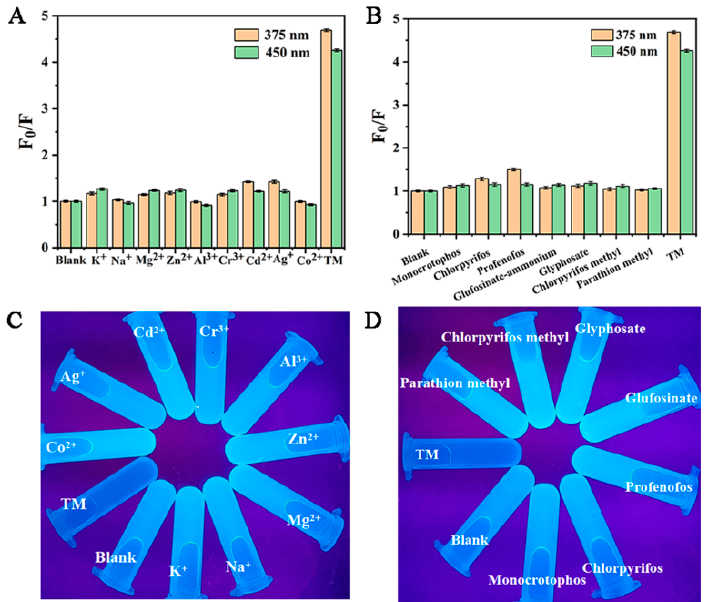
Figure 7. Cu-CDs selectivity to different metal ions ( A ) and to pesticides ( B ), fluorescence images of Cu-CDs solutions with different metal ions ( C ) and Cu-CDs solutions with different pesticides under UV lamp ( D ).